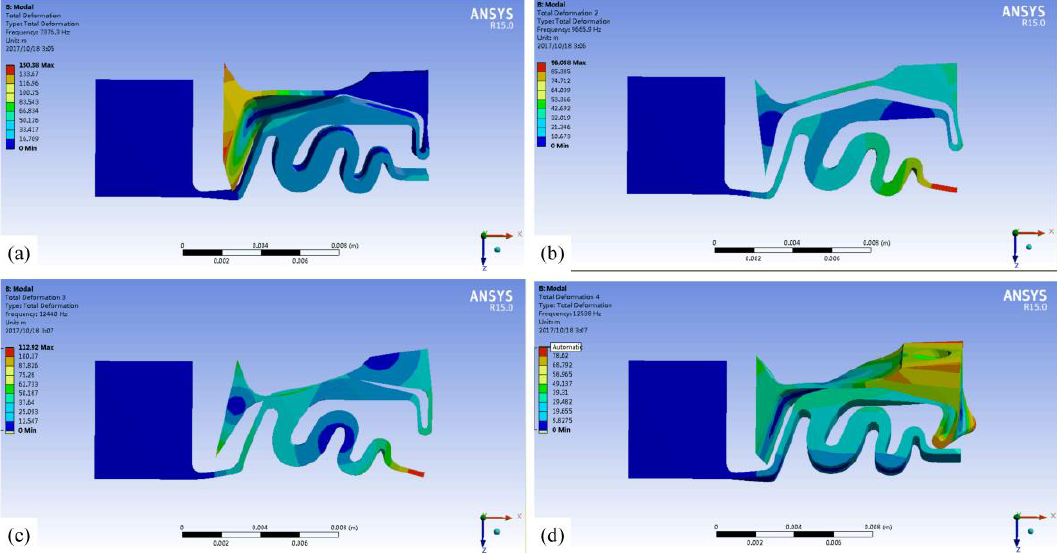
Figure 6. Model shape and frequency of the actuator elastomer. ( a ) f = 7376 Hz. ( b ) f = 9666 Hz. ( c ) f = 12,440 Hz. ( d ) f = 12,538 Hz.